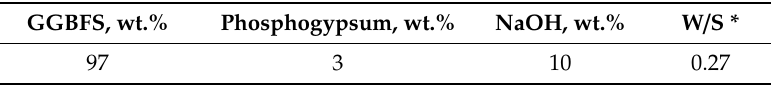
Table 3. The composition of alkali activated GGBFS binder. GGBFS, wt.% Phosphogypsum,